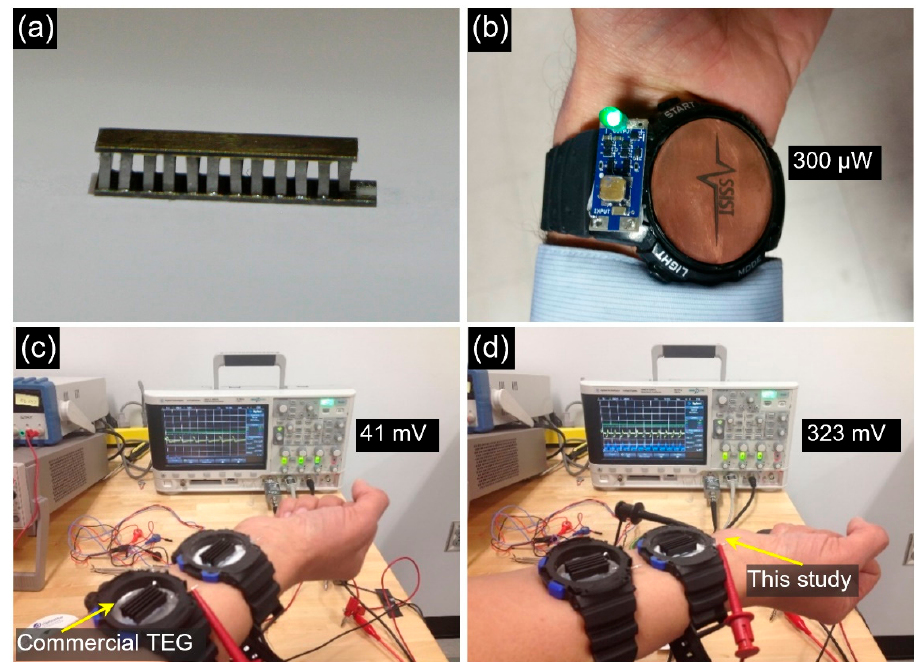
Figure 8. ( a ) Thermoelectric generator (TEG) module made from developed p-type (Bi x Sb 1 − x ) 2 Te